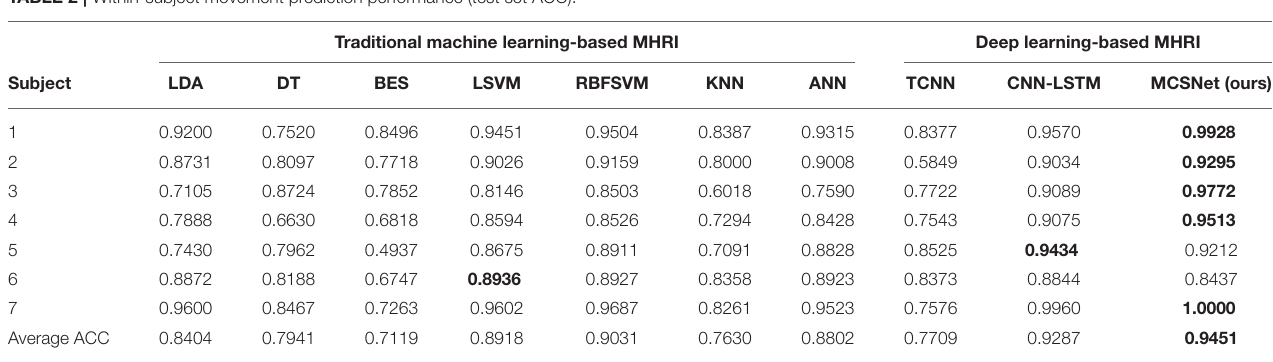
TABLE 2 | Within-subject movement prediction performance (test set